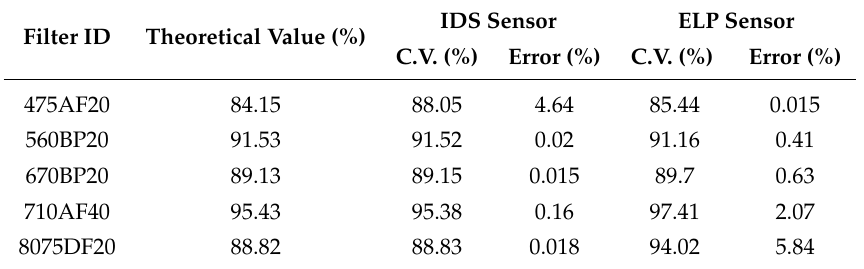
Table 4. Comparison between theoretical and obtained values for each sensor and